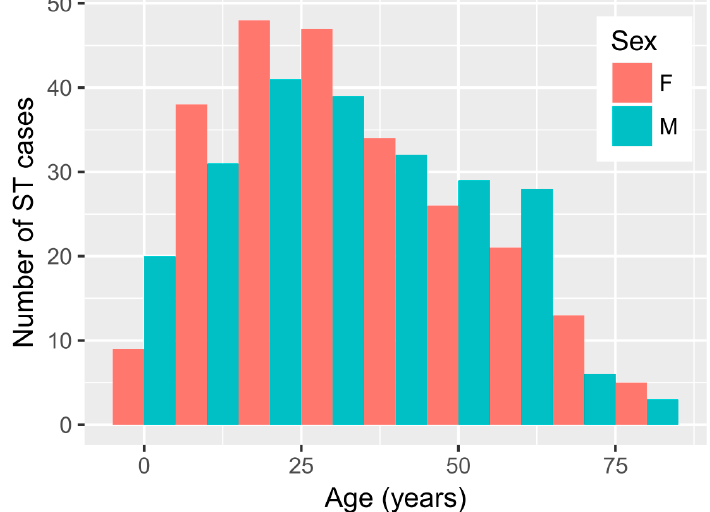
Figure 1. Age distribution of 470 clinically suspected scrub typhus (ST) cases that were positive to the SD Bioline Tsutsugamushi test in Bhutan in 2015.